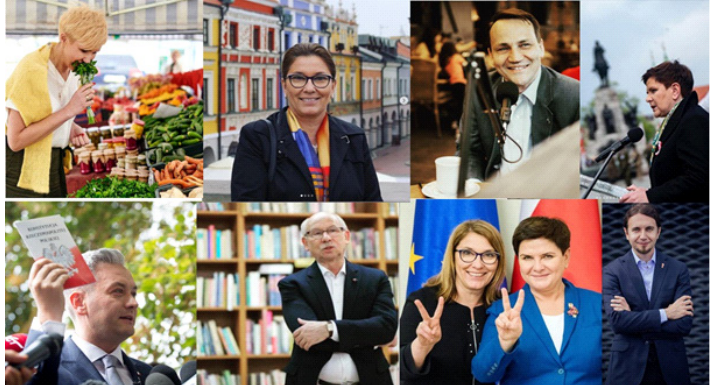
Figure 1. Typical professionally shot self-promotional photos of candidates campaigning ( topos of the party nominee) (source: Instagram